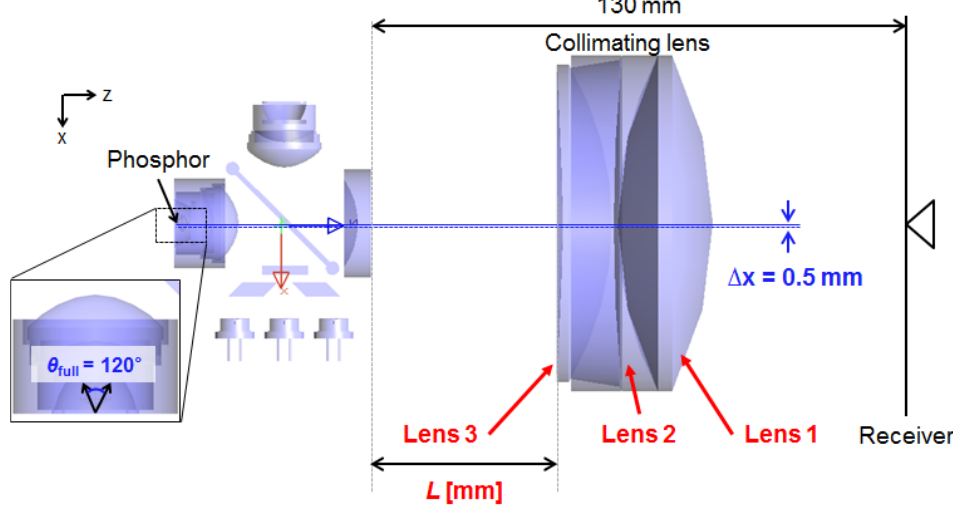
Figure 14. Laser white light module large-area collimating optical system structure.